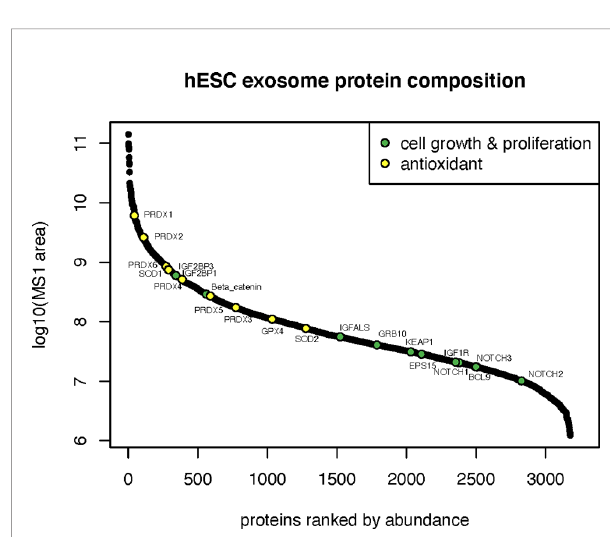
FIGURE 4 | Cell growth, proliferation and antioxidant proteins in hESC- derived EV. Relative abundance of cell growth and proliferation proteins and antioxidant enzymes identi fi ed by proteomic analysis.